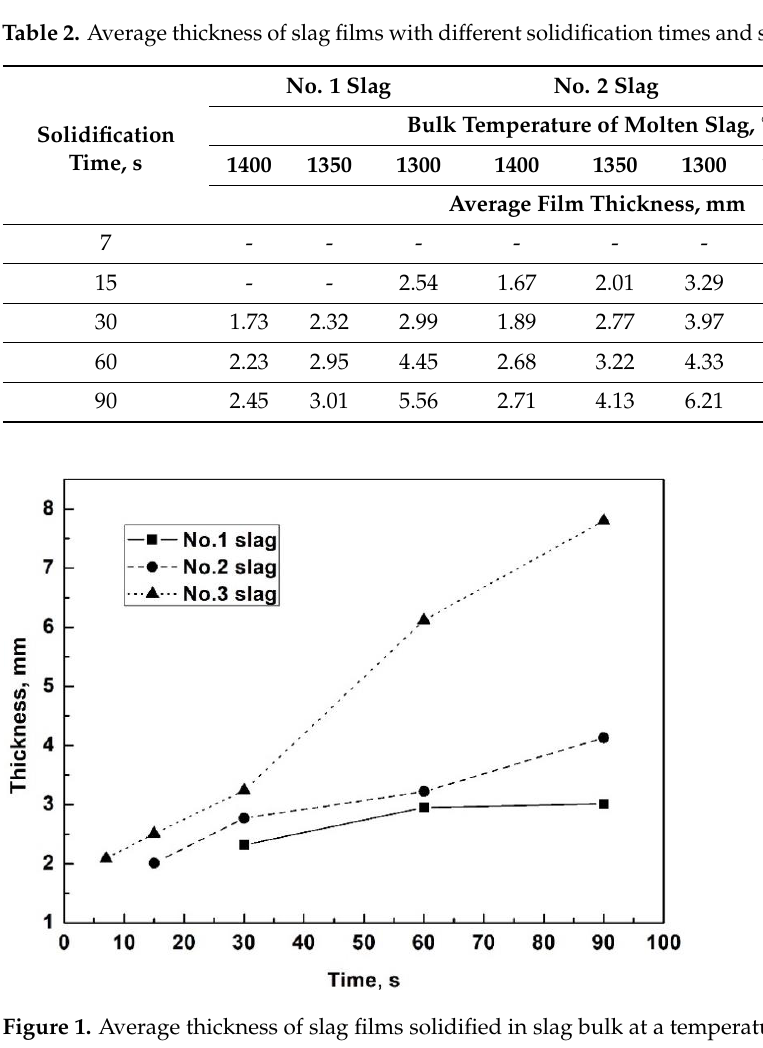
Figure 3. Optical image of crystals dispersed in glassy film (slag bulk temperature 1300 °C). 3.2. Crystals in Slag Films The XRD patterns of typical slag film powders are shown in Figure 4 and the major crystal phases are summarized in Table 3. Calcium fluoride, lithium aluminate, and bar- ium aluminate were the major crystals in most of the films. In the films with an extra 10% alumina (No. 3 slag), spinel (MgAl 2 O 4 ) with a high melting temperature was detected.